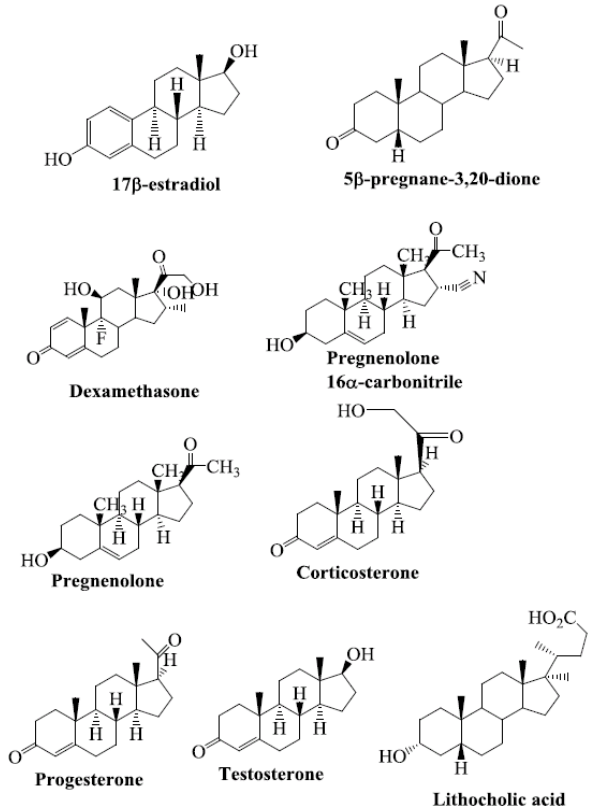
Figure 1. Chemical structures of selected steroid ligands known to activate PXR.